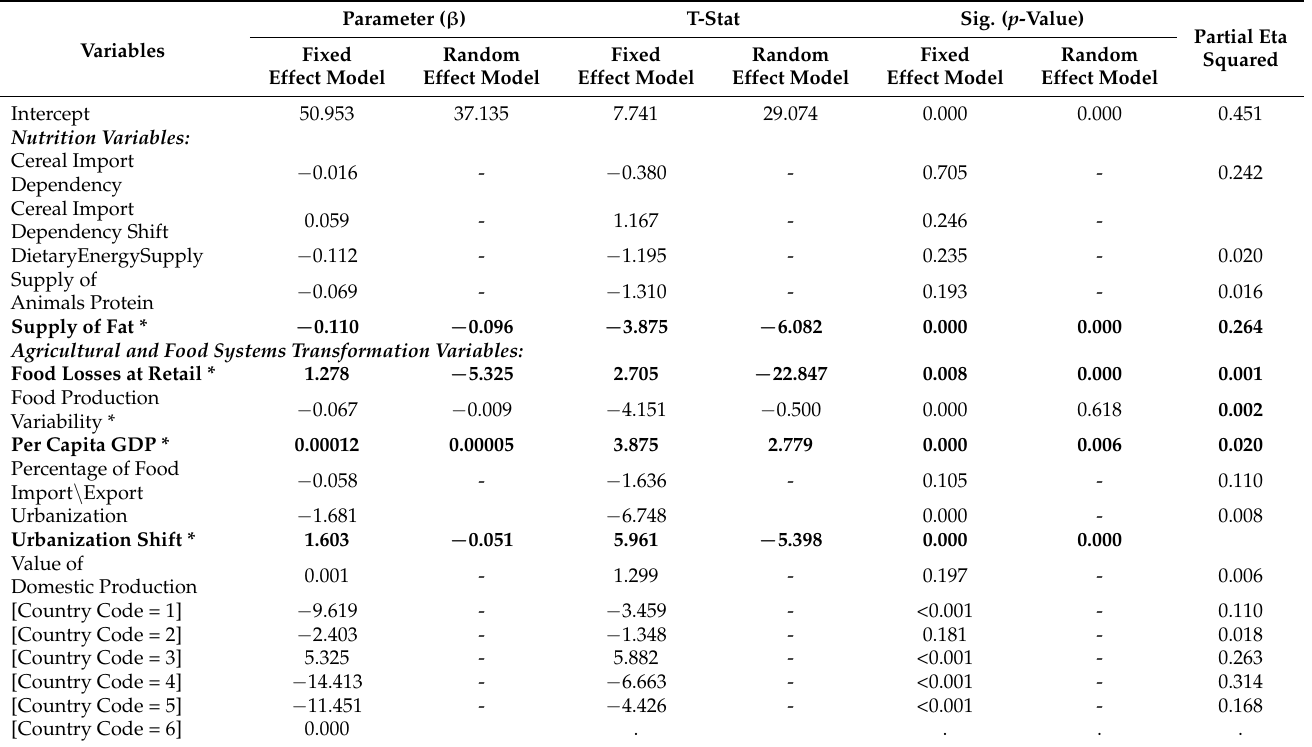
Table 5. Parameter estimates of undernourishment in fixed- and random-effect models results.